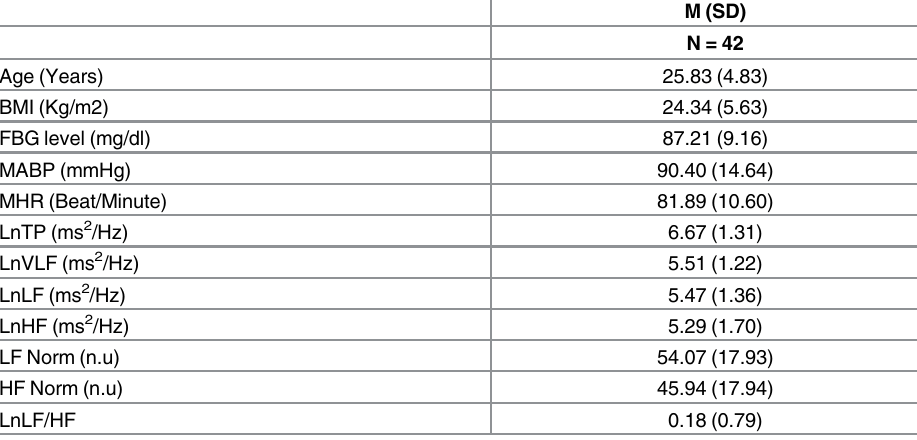
Table 1. Characteristics of studied